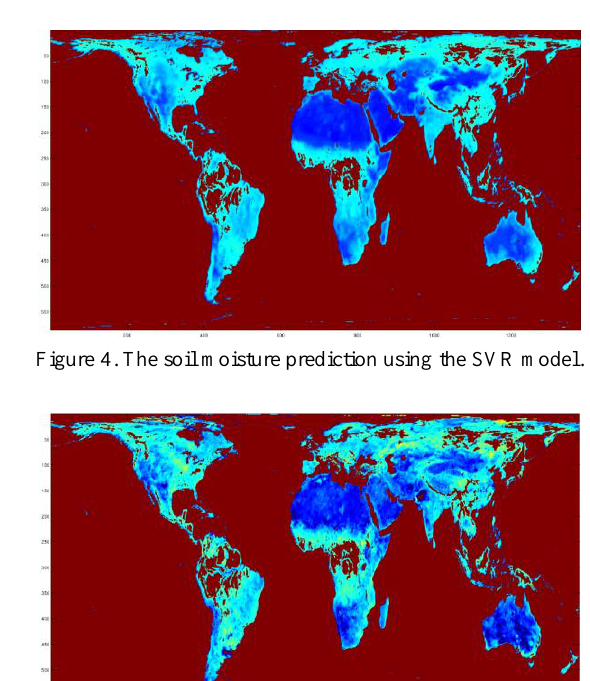
Figure 3. The soil moisture prediction using the CNN model.